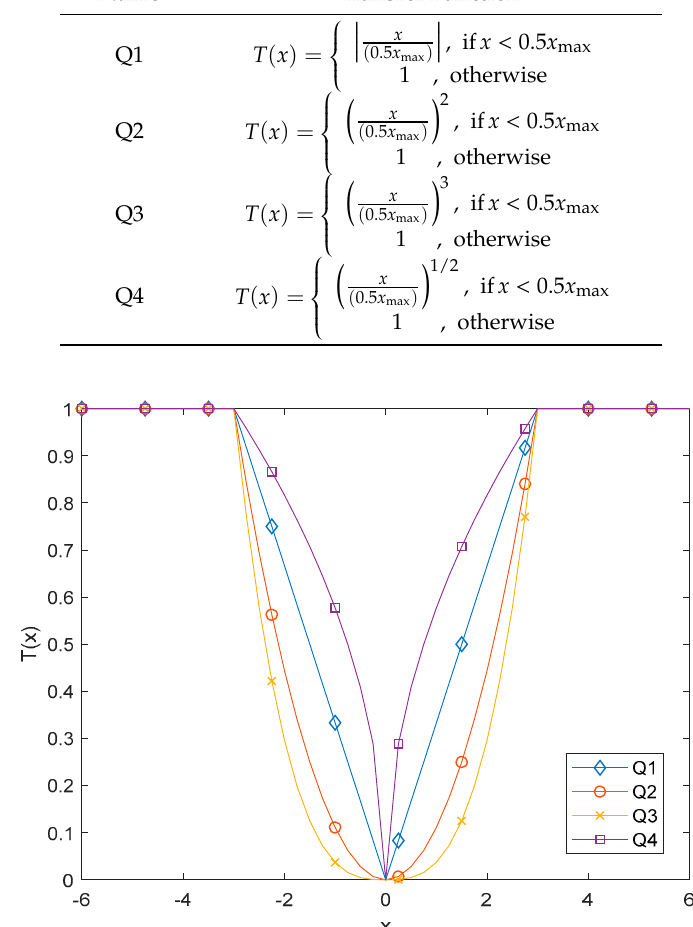
Figure 3. Sample quadratic transfer functions with x max = 6.